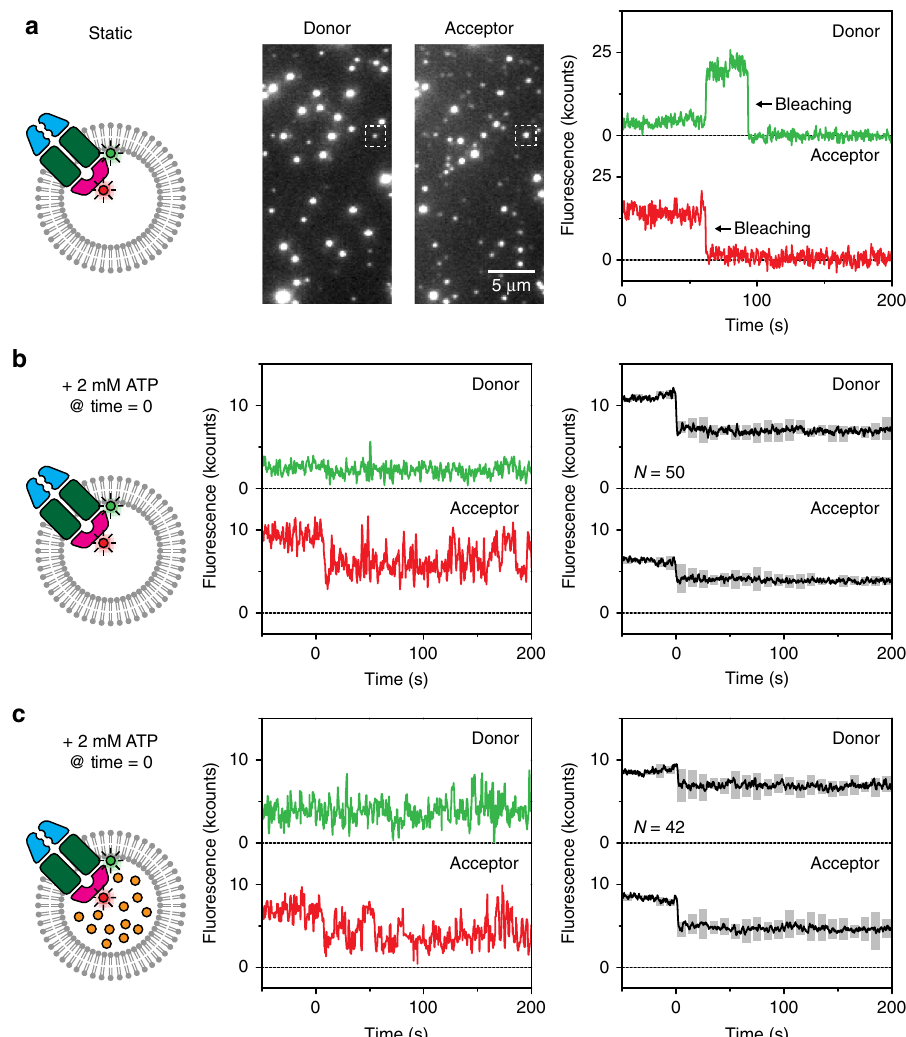
Fig. 2 Complex formation observed with FRET. a A stable complex of BtuCD cys (Alexa Fluor 555) and BtuF (Alexa Fluor 647) was formed when reconstituted in substrate-free liposomes. The middle panel shows a section of a fi eld of view. On excitation of donor fl uorophores (left channel), emission of acceptor fl uorophores was visible (right channel), which is an indication of FRET and thus complex formation. The right panel shows the fl uorescence traces of the spots marked with a square. A 2.5× higher laser power density was used to promote bleaching of the dyes, here visible at ~65 and ~100 s. b The same complex as in a was used, but now ATP and Mg 2+ were introduced at time zero. The total intensity (sum of donor and acceptor fl uorescence) decreased when ATP was present, and dynamics in the signal are visible (middle panel). The right panel shows the average of all traces where a drop in total intensity was observed upon introduction of ATP; the pair of traces shown in the middle panel is one of them. The grey fl oating bars indicate the number of times the signal exceeded a threshold (see Methods), and thus report on the extent of the fl uctuations increasing at positive times. In total, over 1000 fl uorescence traces were analysed. c Similar experiment as described in b , but with 100 µ M vitamin B 12 introduced to the lumen of the